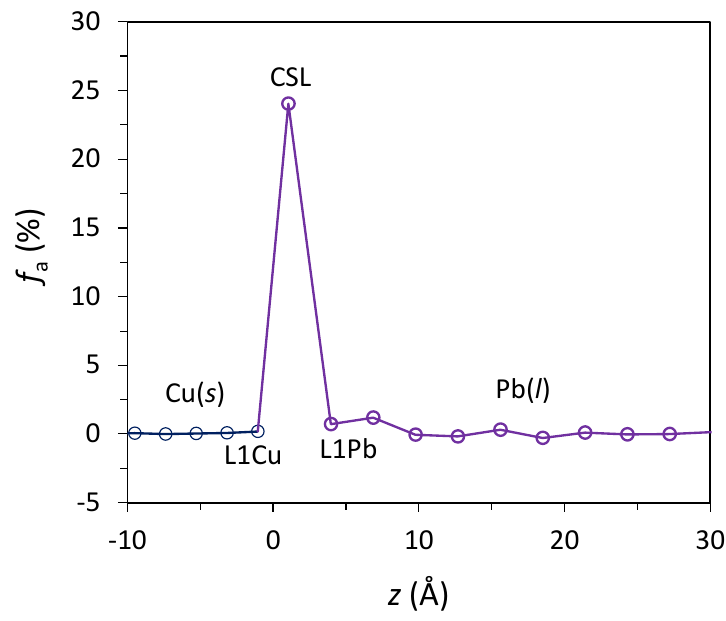
Figure 5. The accommodated misfit, f a , of the individual layer as a function of distance ( z ) from the interface during prenucleation in the Pb( l )/Cu( s ) system equilibrated at 625 K.